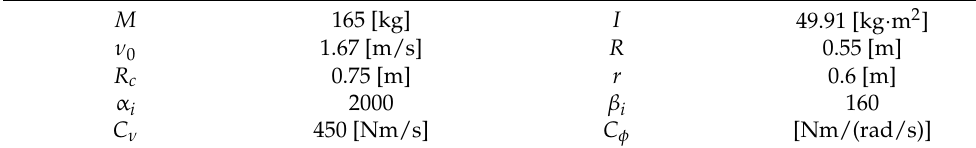
Table 1. Parameters designed in the proposed i E-Wheelchair